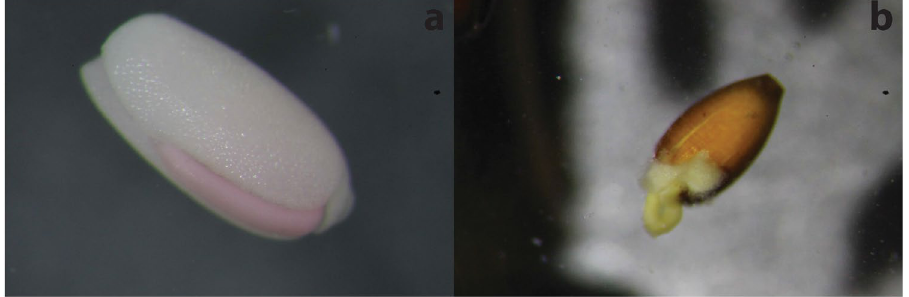
Figure 5. ( a ) A Zostera muelleri seed (with seed coat removed) taken from marine mega-herbivore faeces returned a positive stain, turning the cotyledon pink; ( b ) A germinated Zostera muelleri seed removed from marine mega-herbivore